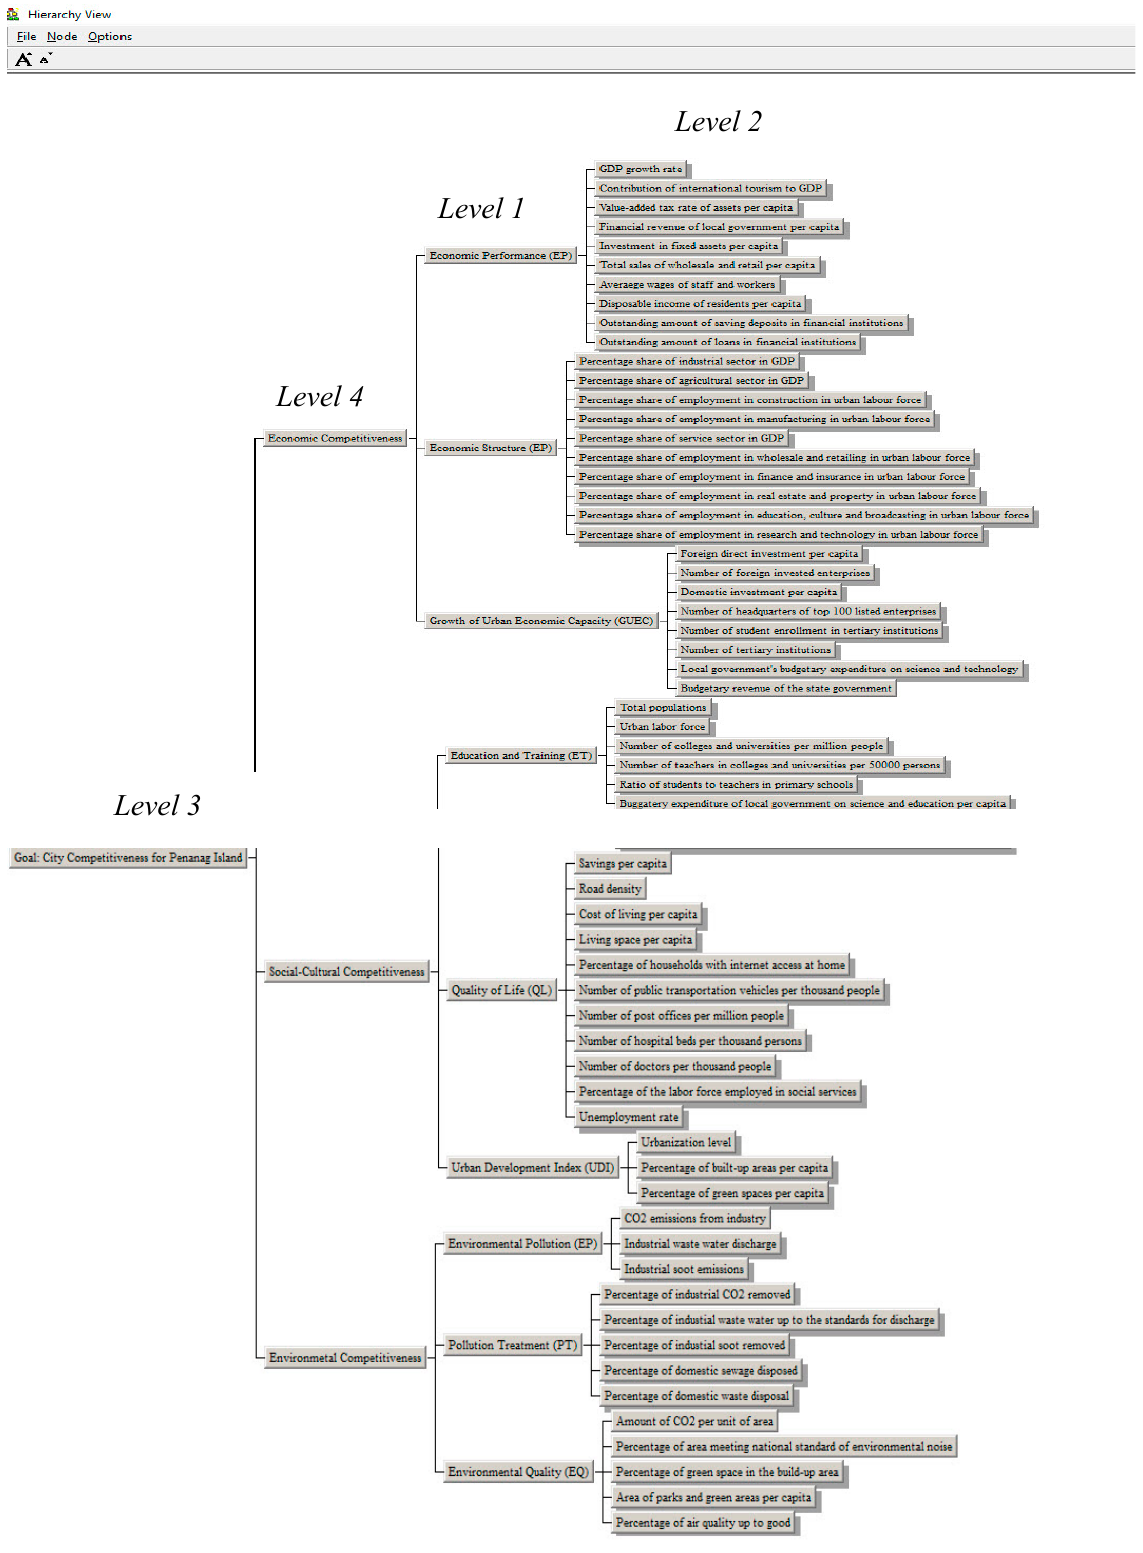
Figure 4. The essential criteria and sub criteria for the urban landscape of Penang Island. The third level of analysis evaluates the performance of each zone across the nine operational components (Table 5). For the sociocultural criterion, the growth of the urban landscape development sub-criterion achieved the greatest performance weight